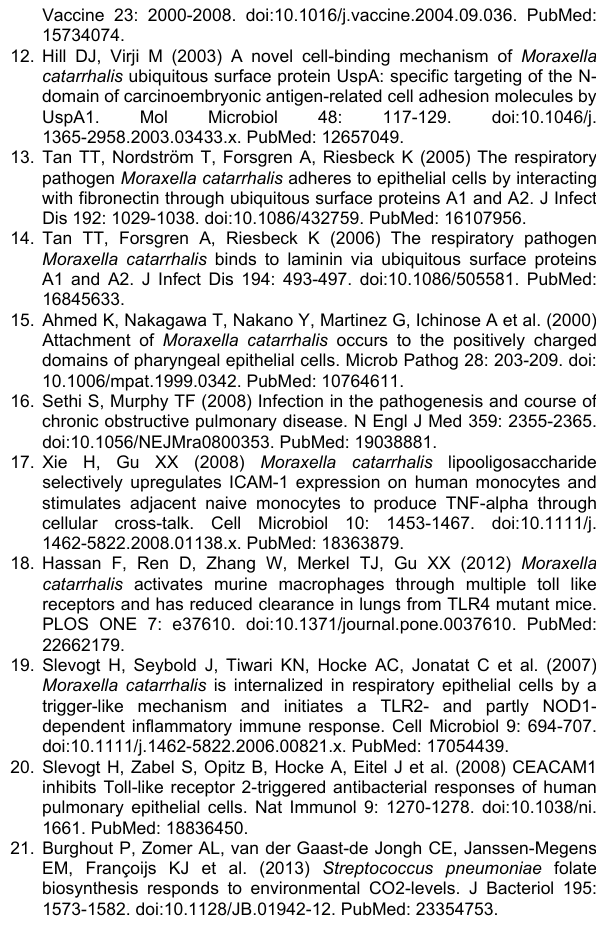
Table S3. Detroit 562 genes induced in response to adherent M. catarrhalis BBH18.